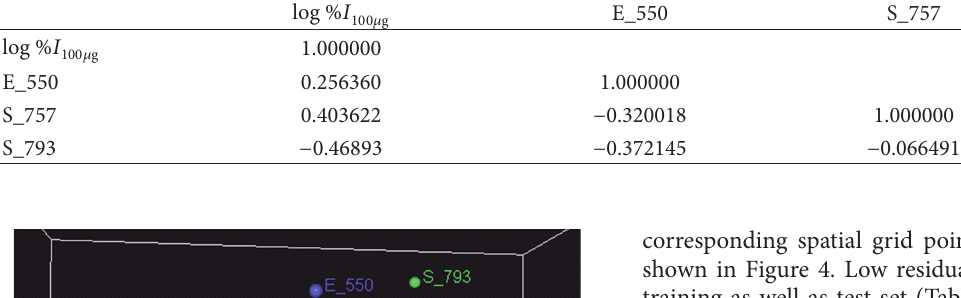
corresponding spatial grid points of 793, 757, and 550